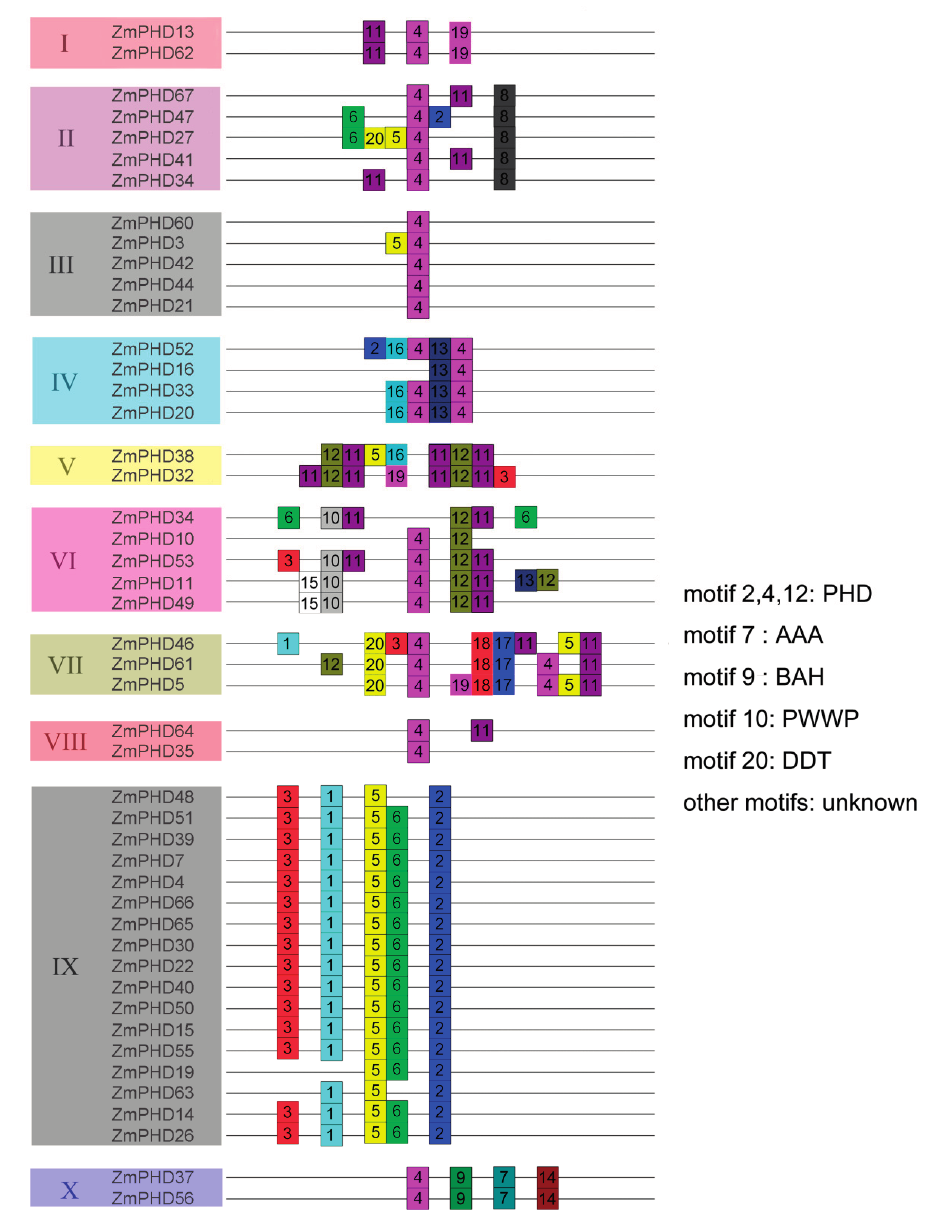
Figure 3. Distribution of conserved motifs in maize PHD members. All motifs were identified by MEME using the complete amino acid sequences of ZmPHD proteins. Different motifs are indicated by different colors boxes numbered 1–20, and the length of each box in the proteins does not represent the actual motif size. The annotation of each motif is listed on the right. PHD: plant homeodomain; AAA: ATPases Associated with diverse cellular Activities; BAH: Bromo-adjacent Homology domain;